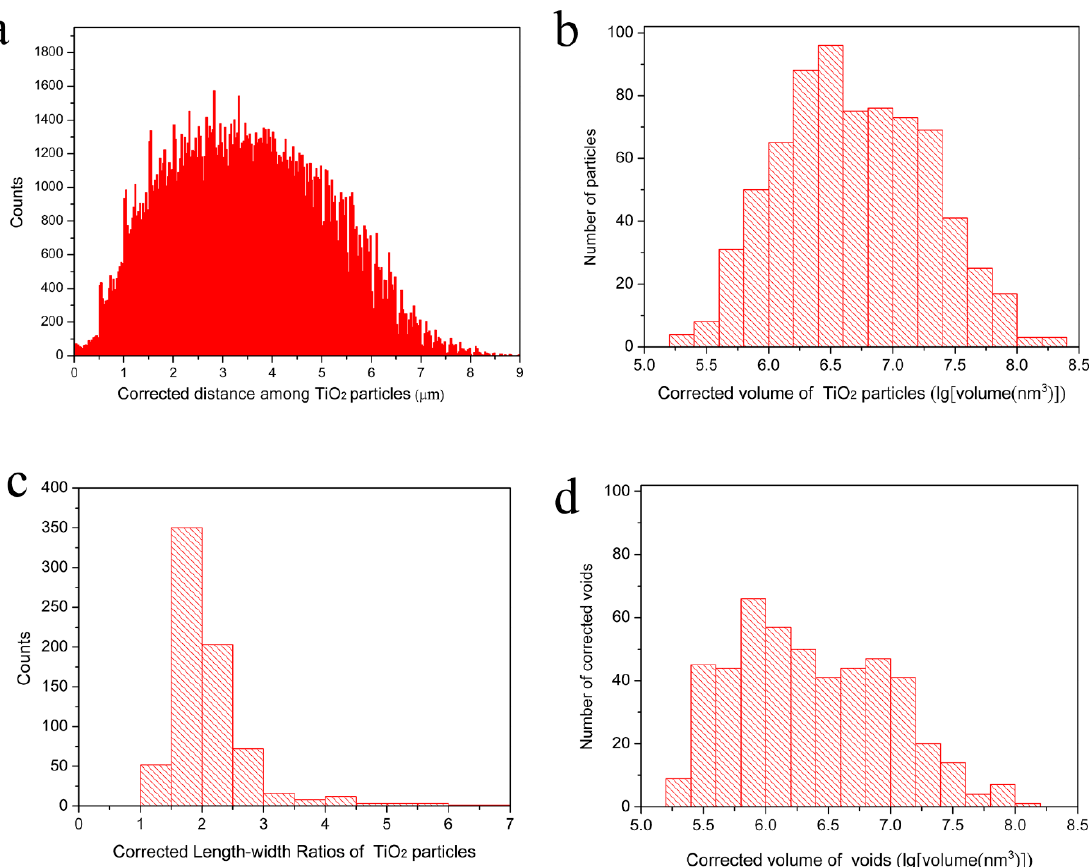
Figure 8. Corrected 3D characterization of the TiO 2 particles and voids within the measured waterborne paint film: ( a ) A histogram of corrected distribution of distances among individual TiO 2 particles; ( b ) A histogram of the corrected volume distribution of the TiO 2 particles; ( c ) A histogram of the corrected length–width ratios of the measured TiO 2 particles; ( d ) A histogram of the corrected volume distribution of the voids.